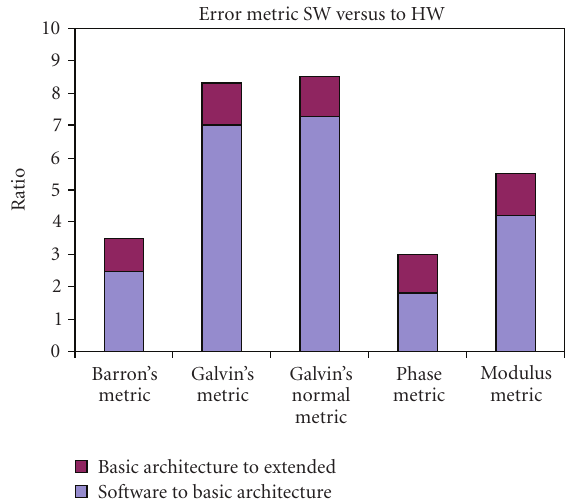
Figure 6: Quality of di ff erent implementations.